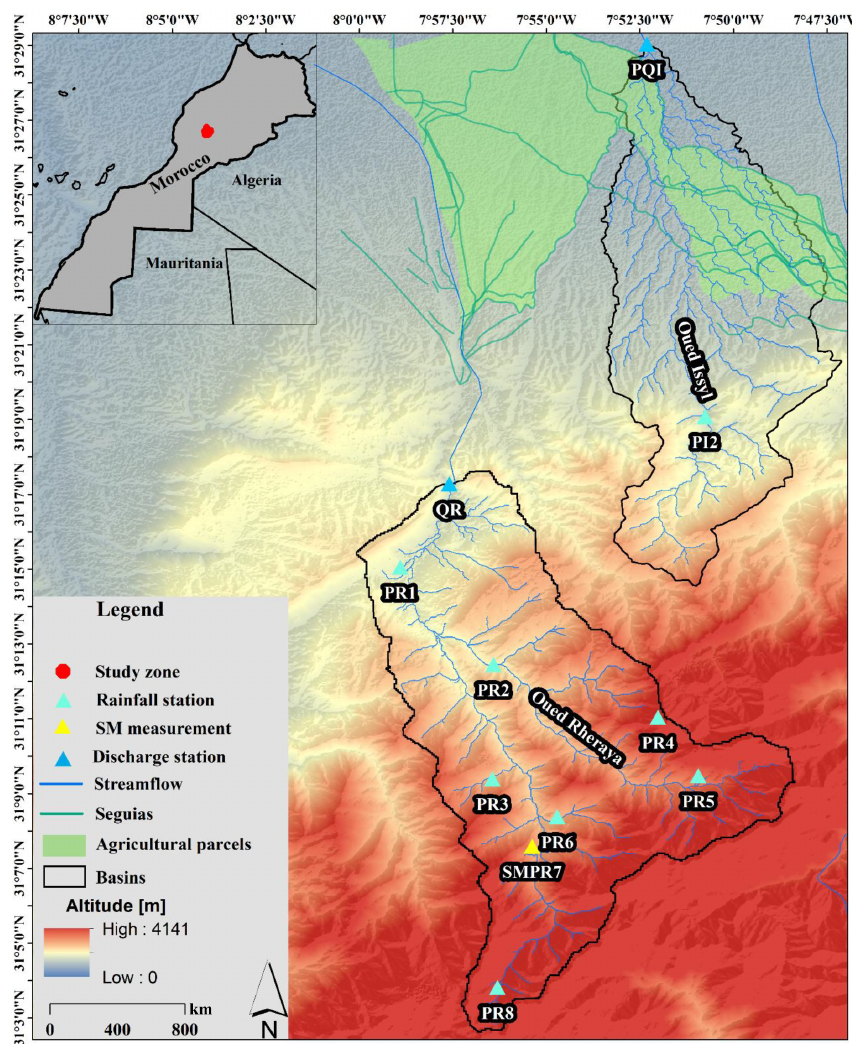
Figure 1. Location of Rheraya and Issyl basins, the seguia network, the agricultural parcels, and the hydrometeorological network – PR: rainfall station in Rheraya; SMPR: soil moisture measurement + rainfall station in Rheraya; PQI: rainfall and discharge station in Issyl; QR: discharge station in